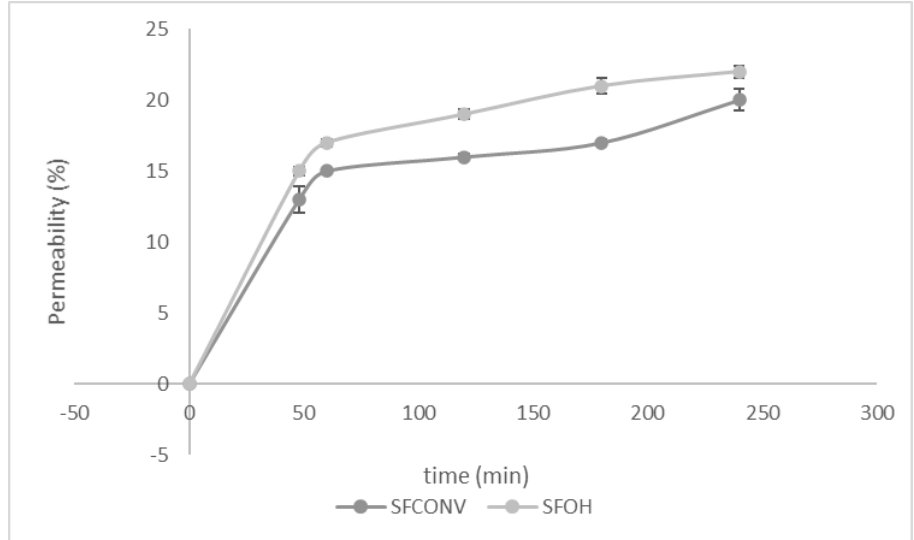
Figure 5. Cumulative permeability of cells to SFOH and SFCONV samples.